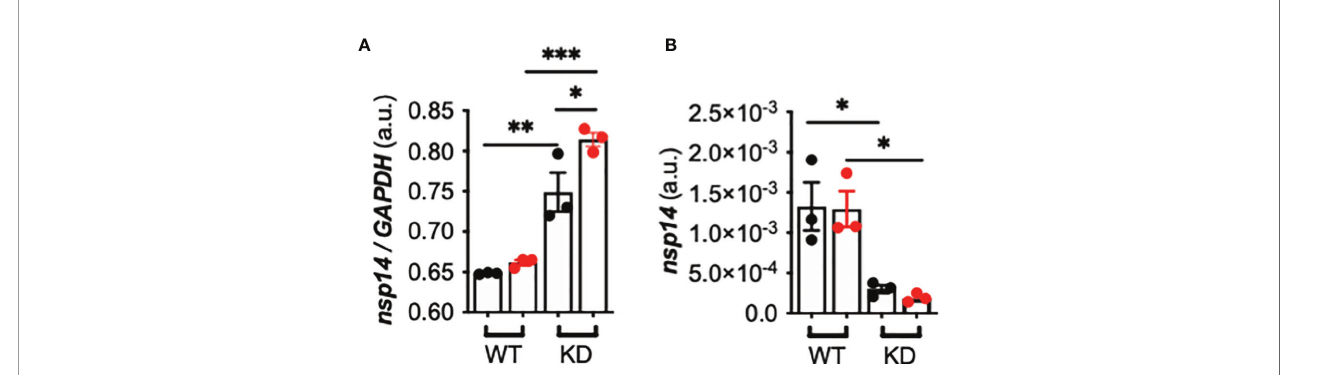
FIGURE 4 | Effect of TMPRSS2 induction by P. aeruginosa fl agellin on SARS-CoV-2 infectivity in CFTR -de fi cient Calu-3 cells. (A) Intracellular nsp14/GAPDH and (B) apical (supernatant) nsp14 mRNA expression in Calu-3- CFTR -WT (reference group) and - CFTR -KD cells grown at the air-liquid interface and either not stimulated (black circle) or stimulated (red circle) for 16 h with Pa -F 50 ng/mL), and then infected for 24 h with SARS-CoV-2 (multiplicity of infection = 1) ( n = 3, ANOVA with Bonferroni ’ s multiple-comparison test, * P < 0.05, ** P < 0.01, *** P < 0.001).